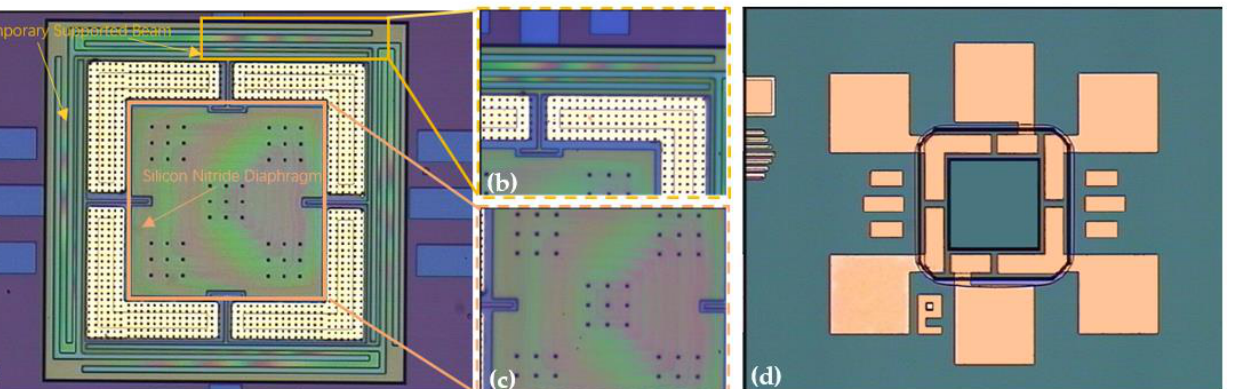
Figure 7. Process flow of the reroute substrate. ( a ) Oxidation to form the hard mask; ( b ) formation